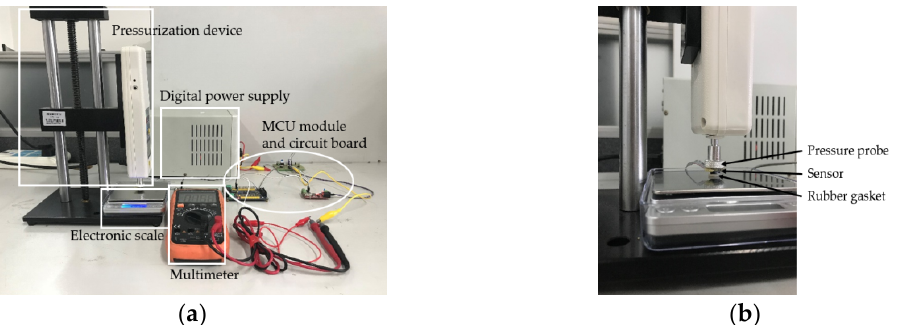
Figure 6. Pressure calibration experiment. ( a ) Experiment devices; ( b ) close view of device.